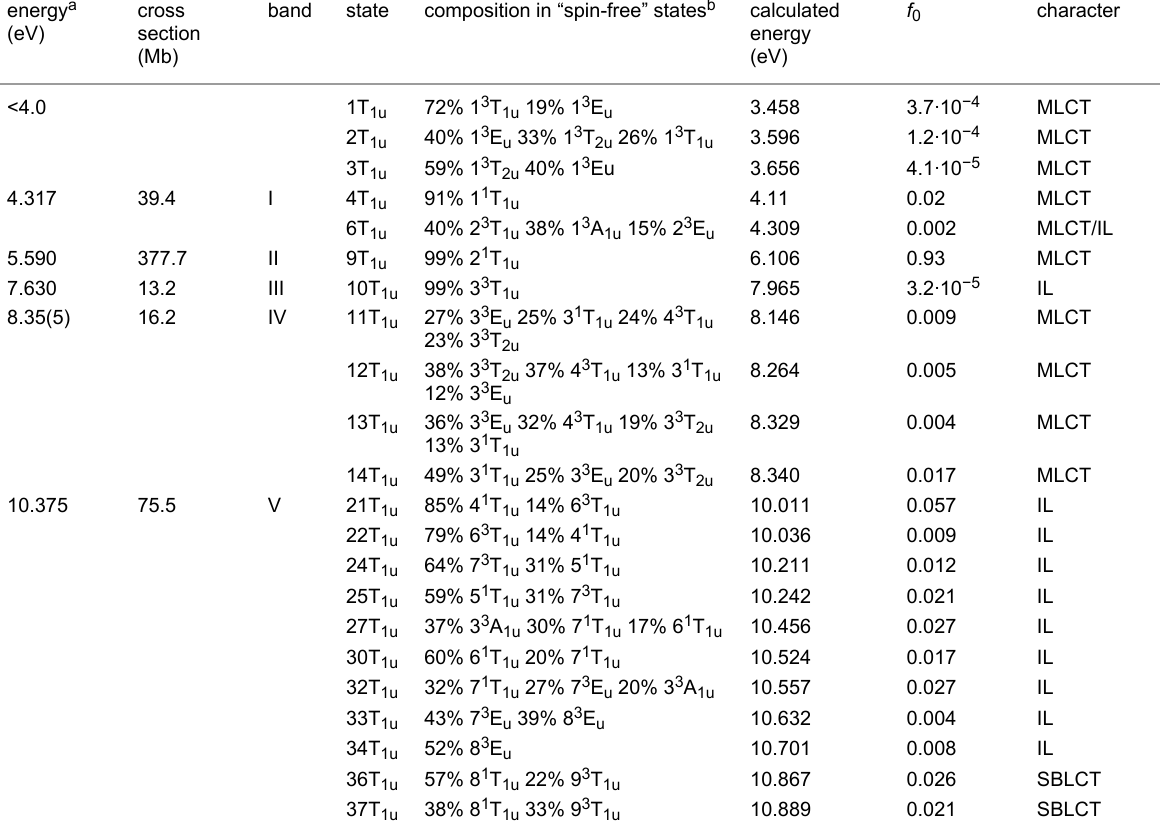
Table 1: TDDFT vertical transition energies and associated oscillator strengths ( f 0 ) of the low-lying “spin–orbit” excited states of W(CO) 6 and assign- ment of the experimental spectrum. energy a cross band state composition in “spin-free” states b (eV) section (Mb)